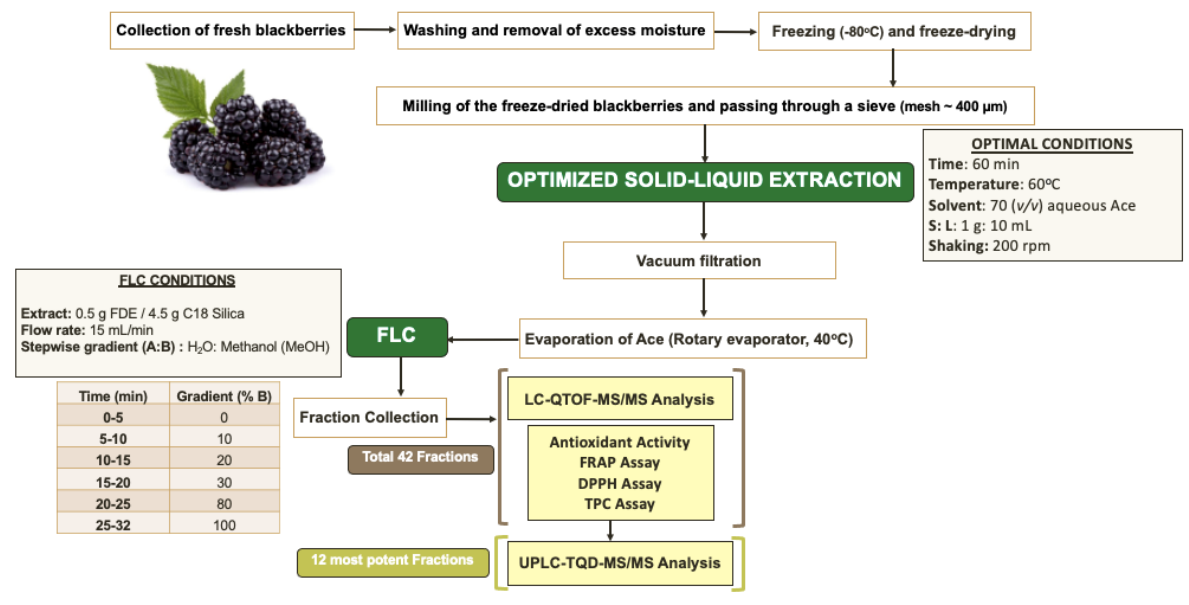
Figure 4. Schematic flow chart illustrating the optimized extraction process, flash fractionation, and analysis of the blackberry phenolic-rich fractions. Ace = acetone, S = solid, L = liquid, FDE = freeze dried extract.